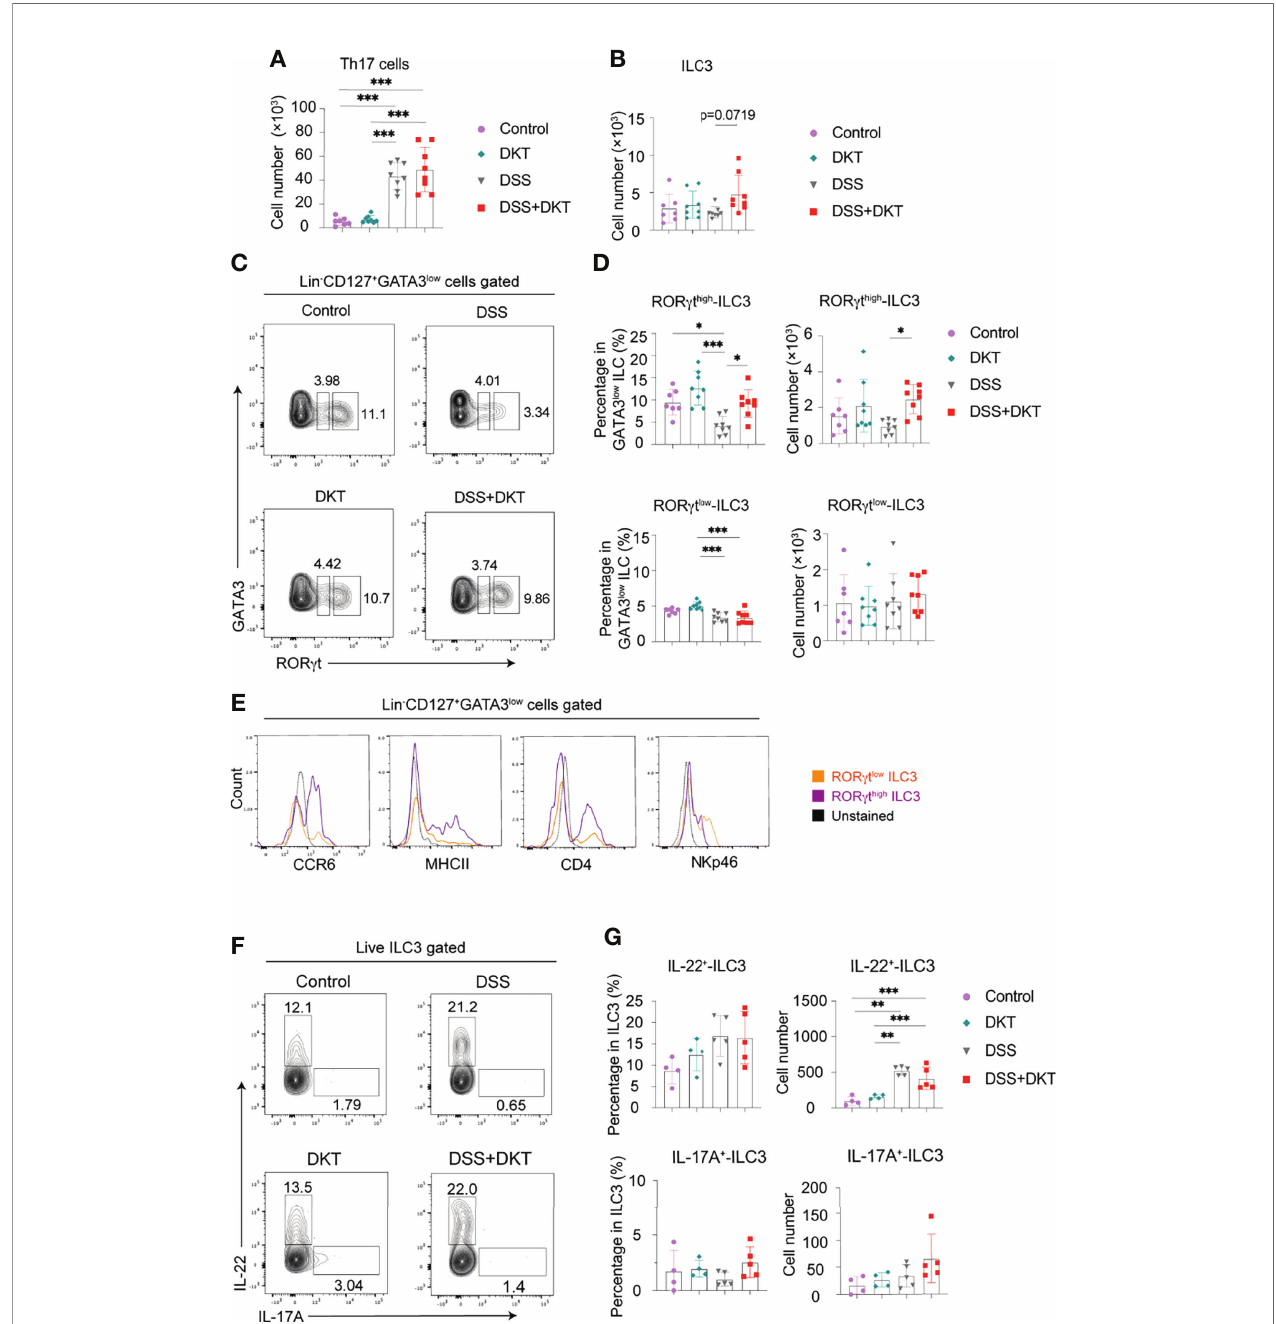
FIGURE 4 | DKT signi fi cantly increases colonic ROR g t high -ILC3 which resembles CCR6 + ILC3. (A) Absolute cell numbers of colonic Th17 cells isolated from the lamina propria region (Control N=7, DKT N=8, DSS N=8, DKT+DSS N=8). (B) Absolute cell numbers of colonic ILC3s isolated from the lamina propria region (Control N=7, DKT N=8, DSS N=8, DKT+DSS N=8). (C) Representative fl ow cytometry plots for gating colonic ILC3, and the two subpopulations of ROR g t low and ROR g t high -ILC3s based on the intensity of the transcription factor ROR g t. See Supplementary Figure 2A for details on the gating strategy. (D) Frequency and absolute cell numbers of ROR g t high and ROR g t low -ILC3s (Control N=7, DKT N=8, DSS N=8, DKT+DSS N=8). (E) Representative histogram plots showing the expression of the surface markers CCR6, MHCII, CD4, and NKp46 by naive colonic ILC3s to discriminate the two ILC3 subpopulations, NKp46 + ILC3 (or NCR + ILC3) and CCR6 + ILC3 (or LTi-like cell) (N=6). (F) Representative fl ow cytometry plots for IL-22 + - and IL-17A + -producing ILC3s of the four experimental groups using Rorc GFP/+ mice. (G) Frequency and absolute cell numbers of IL-22 + - and IL-17A + -producing ILC3s (Control N=4, DKT N=4, DSS N=5, DKT+DSS N=5). Each symbol (A, B, D, G) represents data from an individual mouse. (A – D) , results are pooled from two independent experiments with three to four mice in each experimental group. Graphs (A, B, D, G) show means SEM; *p<0.05, **p<0.01, and ***p<0.001. Statistical analysis was performed using One-way ANOVA with Tukey ’ s multiple comparisons